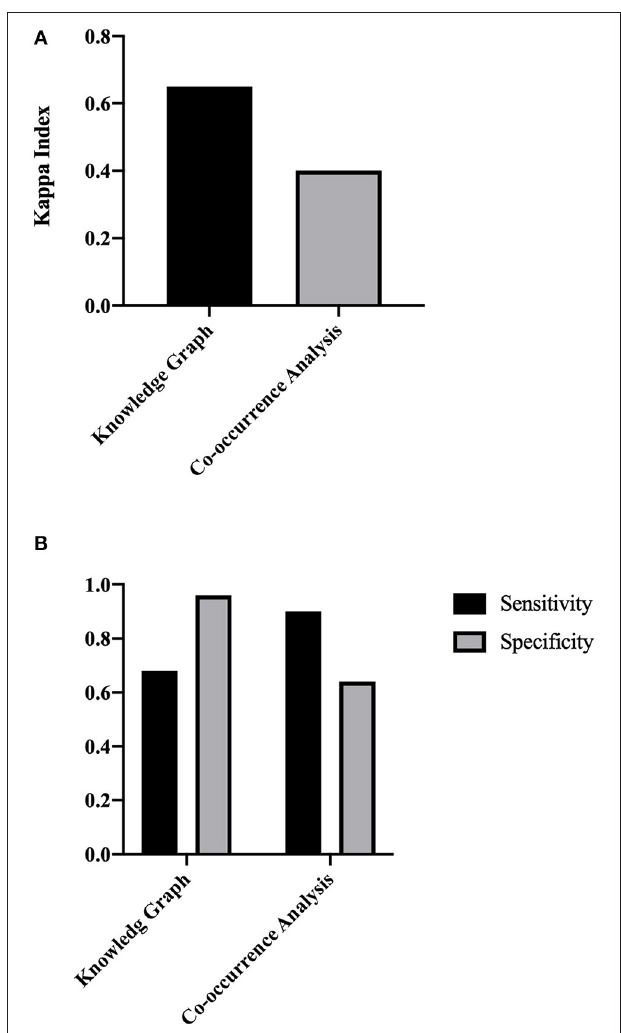
FIGURE 6 | The concordance evaluation of the ADR discovery based on TBKG. (A) The Kappa index of TBKG compared with the co-occurrence analysis. (B) The sensitivity and specificity of TBKG compared with the co-occurrence